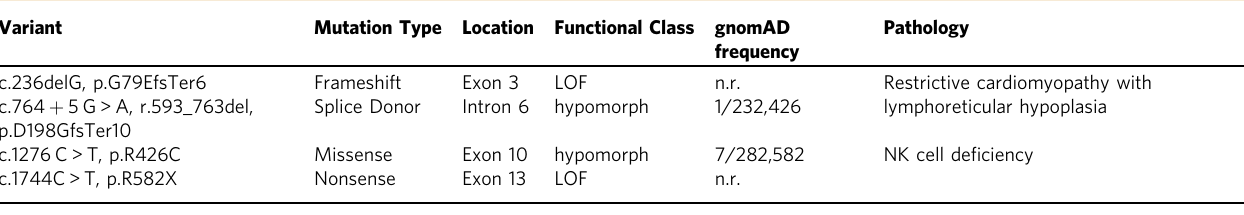
Table 1 MCM10 patient variants associated with NKD and fetal RCM.